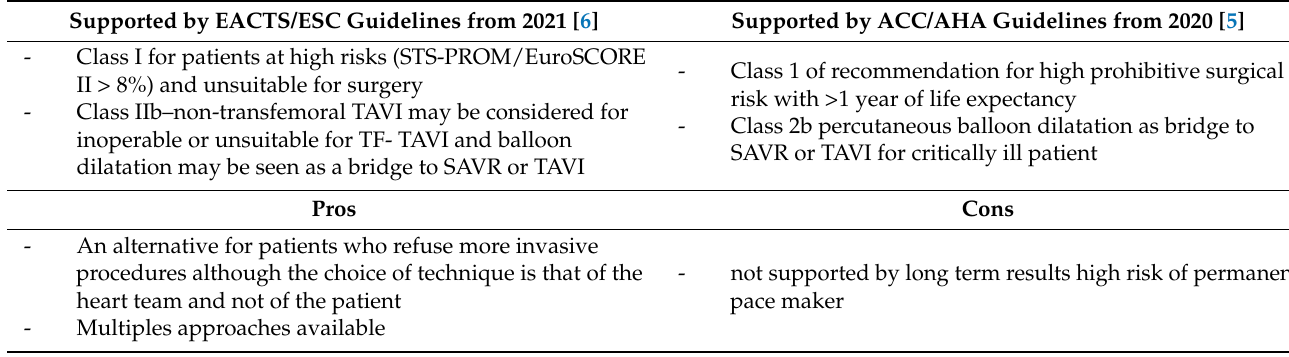
Table 6. Decision Making Algorithm. TAVI for middle-aged patients.